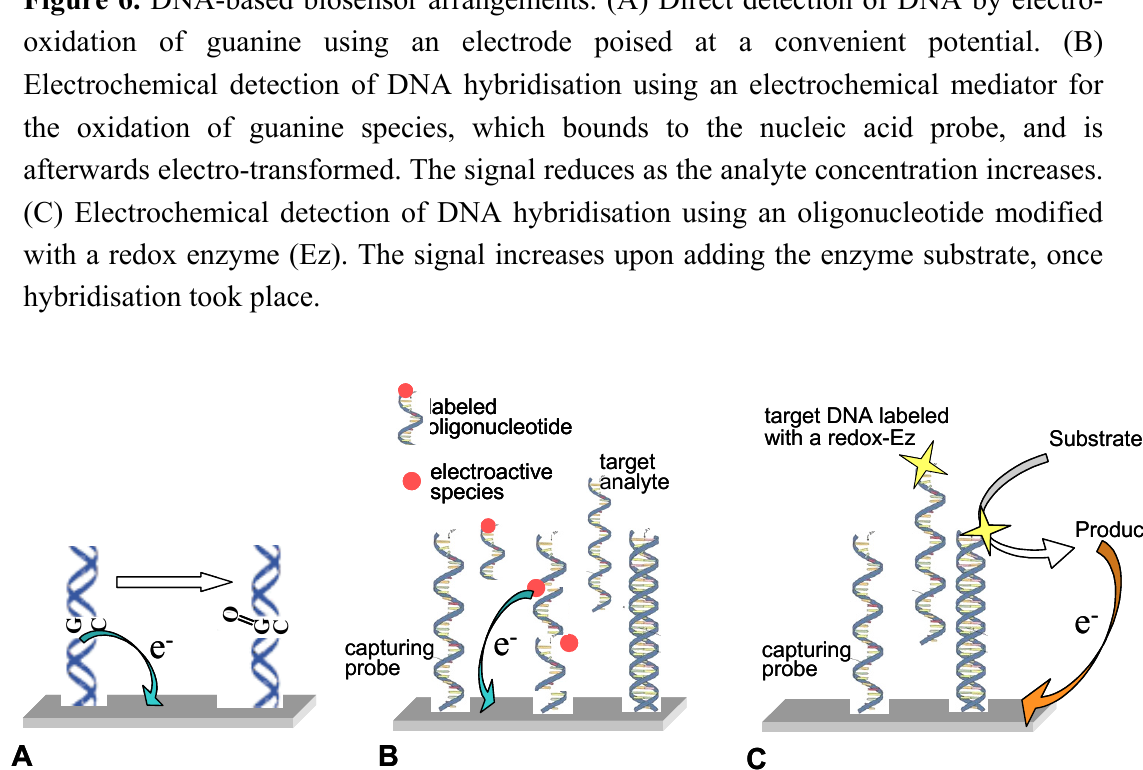
Figure 6. DNA-based biosensor arrangements. (A) Direct detection of DNA by electro- oxidation of guanine using an electrode poised at a convenient potential. (B) Electrochemical detection of DNA hybridisation using an electrochemical mediator for the oxidation of guanine species, which bounds to the nucleic acid probe, and is afterwards electro-transformed. The signal reduces as the analyte concentration